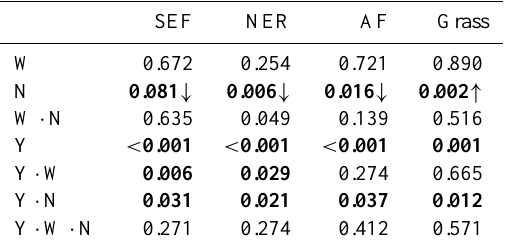
Table 1. Results (p-values) of three-way ANOVAs on the effects of warming (W), N addition (N), year (Y), and their interactions on standard monoterpene emission factor (SEF), natural monoter- pene emission rate (NER), green A. Frigida biomass (AF) and green grass biomass. Arrow direction shows the significantly and marginally positive ( ↑ ) or negative ( ↓ ) effects, which are high- lighted in bold type.